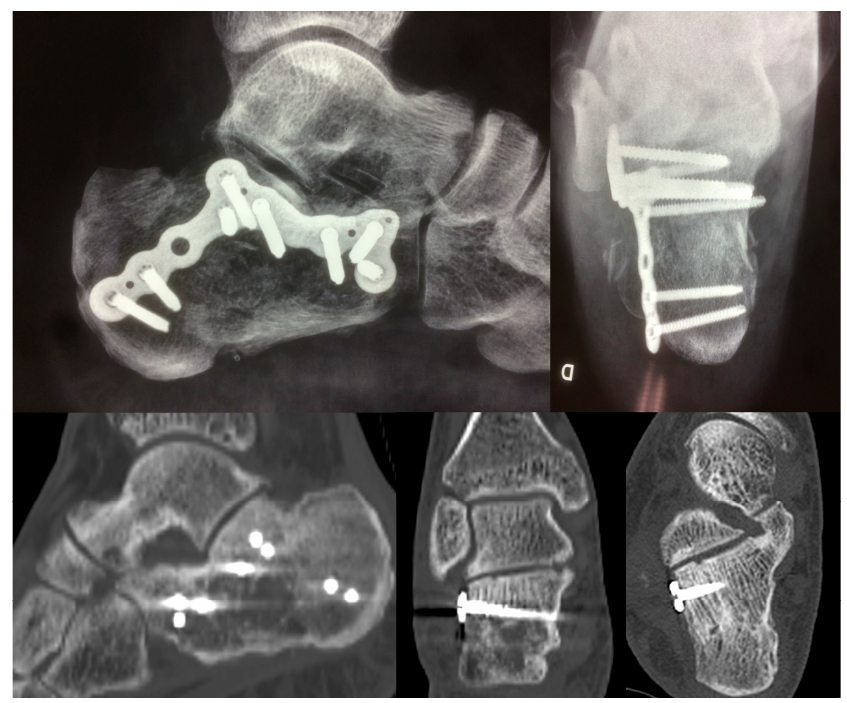
Figure 4. Postoperative X-ray and CT images.